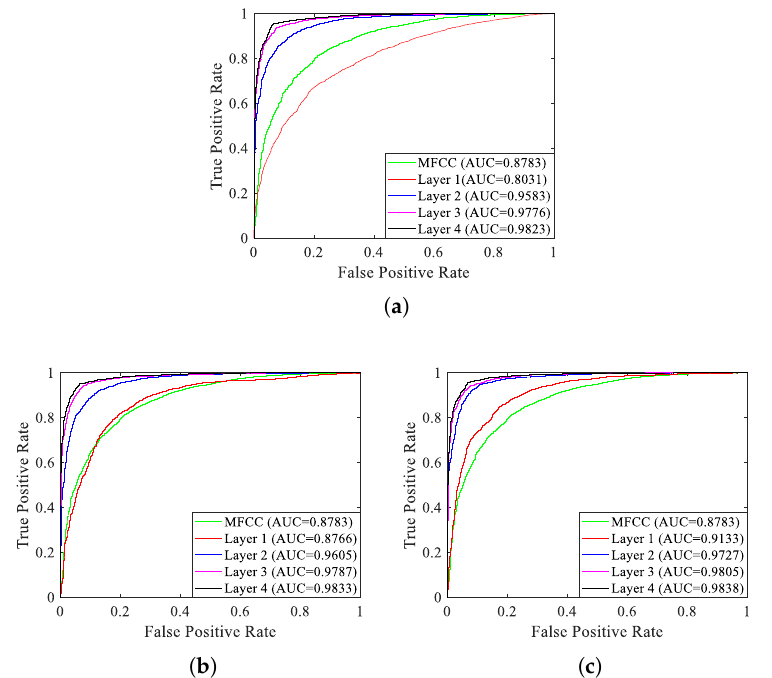
Figure 17. ROC curves of each layer of the model. ( a ) Unsupervised pre-training. ( b ) Fine-tuning with the traditional supervised training algorithm. ( c ) Fine-tuning with the supervised feature- separation algorithm.